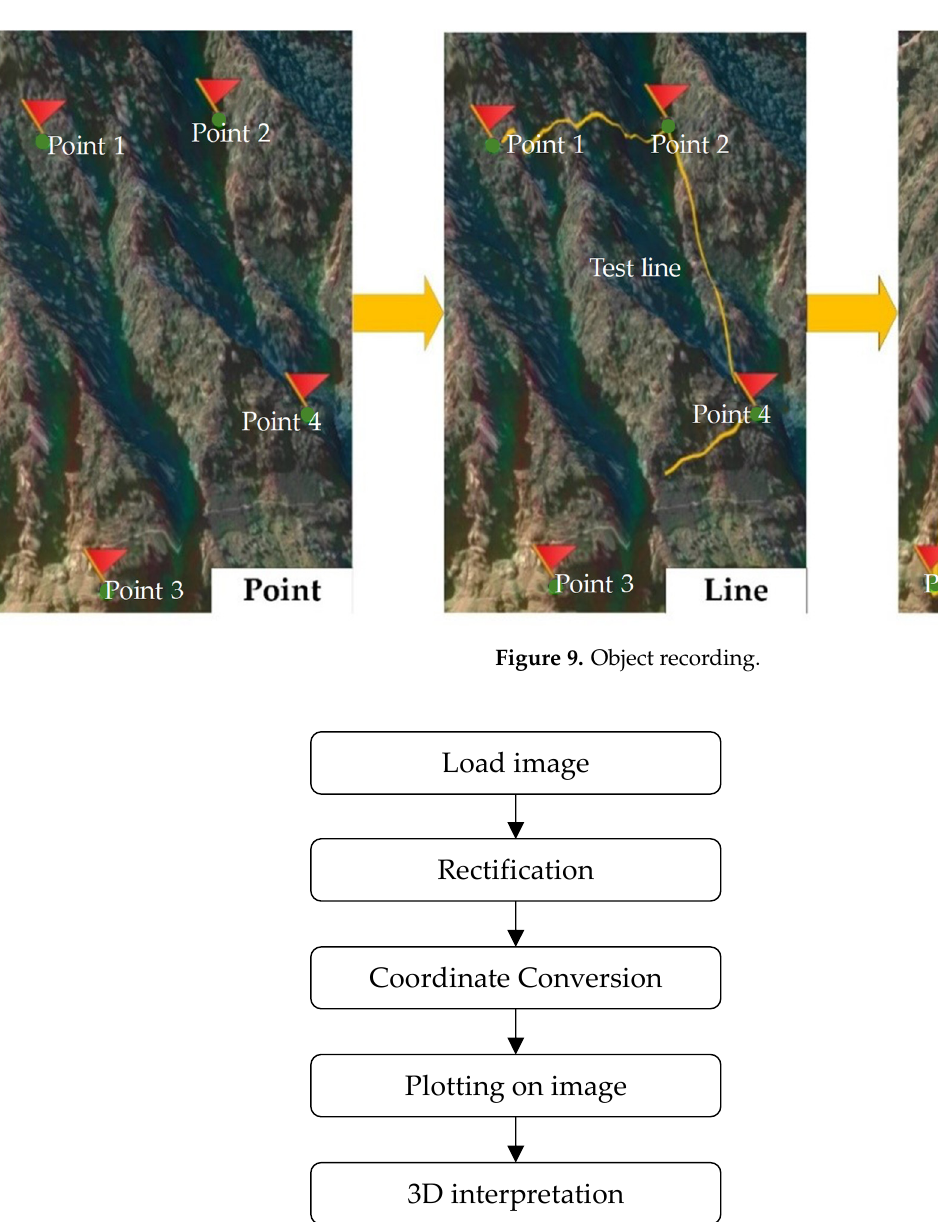
Figure 9. Object recording.